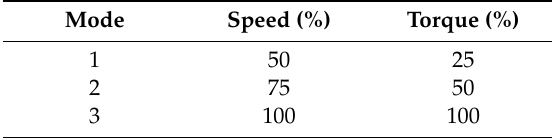
Table 1. The torques and the speeds given in % of rated values in three modes. Mode Speed (%) Torque